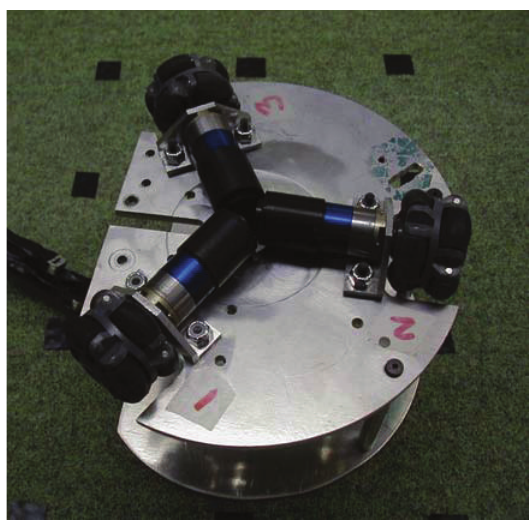
Figure 1: Robocup robot